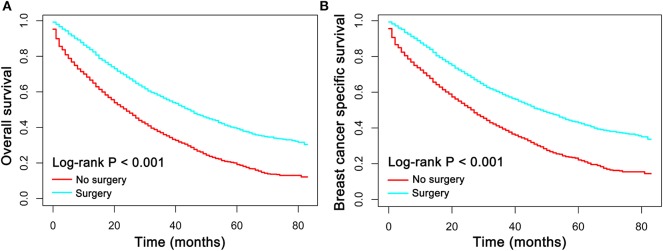
(A) Overall survival (OS) and (B) breast cancer specific survival (BCSS) curves plotted by Kaplan-Meier method for patients received surgical treatment or not.